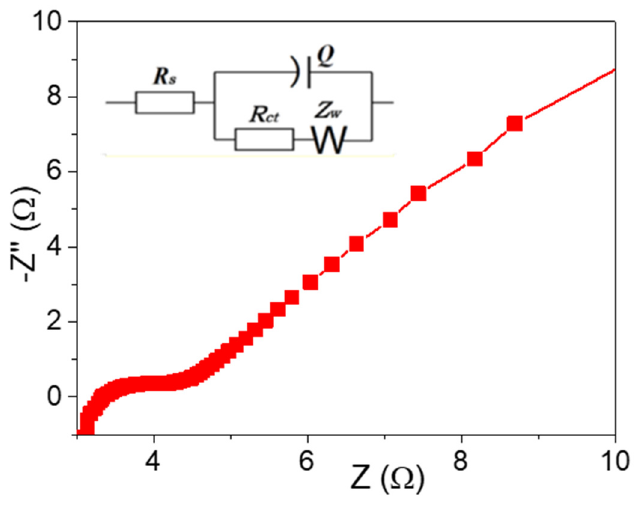
Figure 8. Nyquist plot of ZnO@CFT nano-flowers electrode.